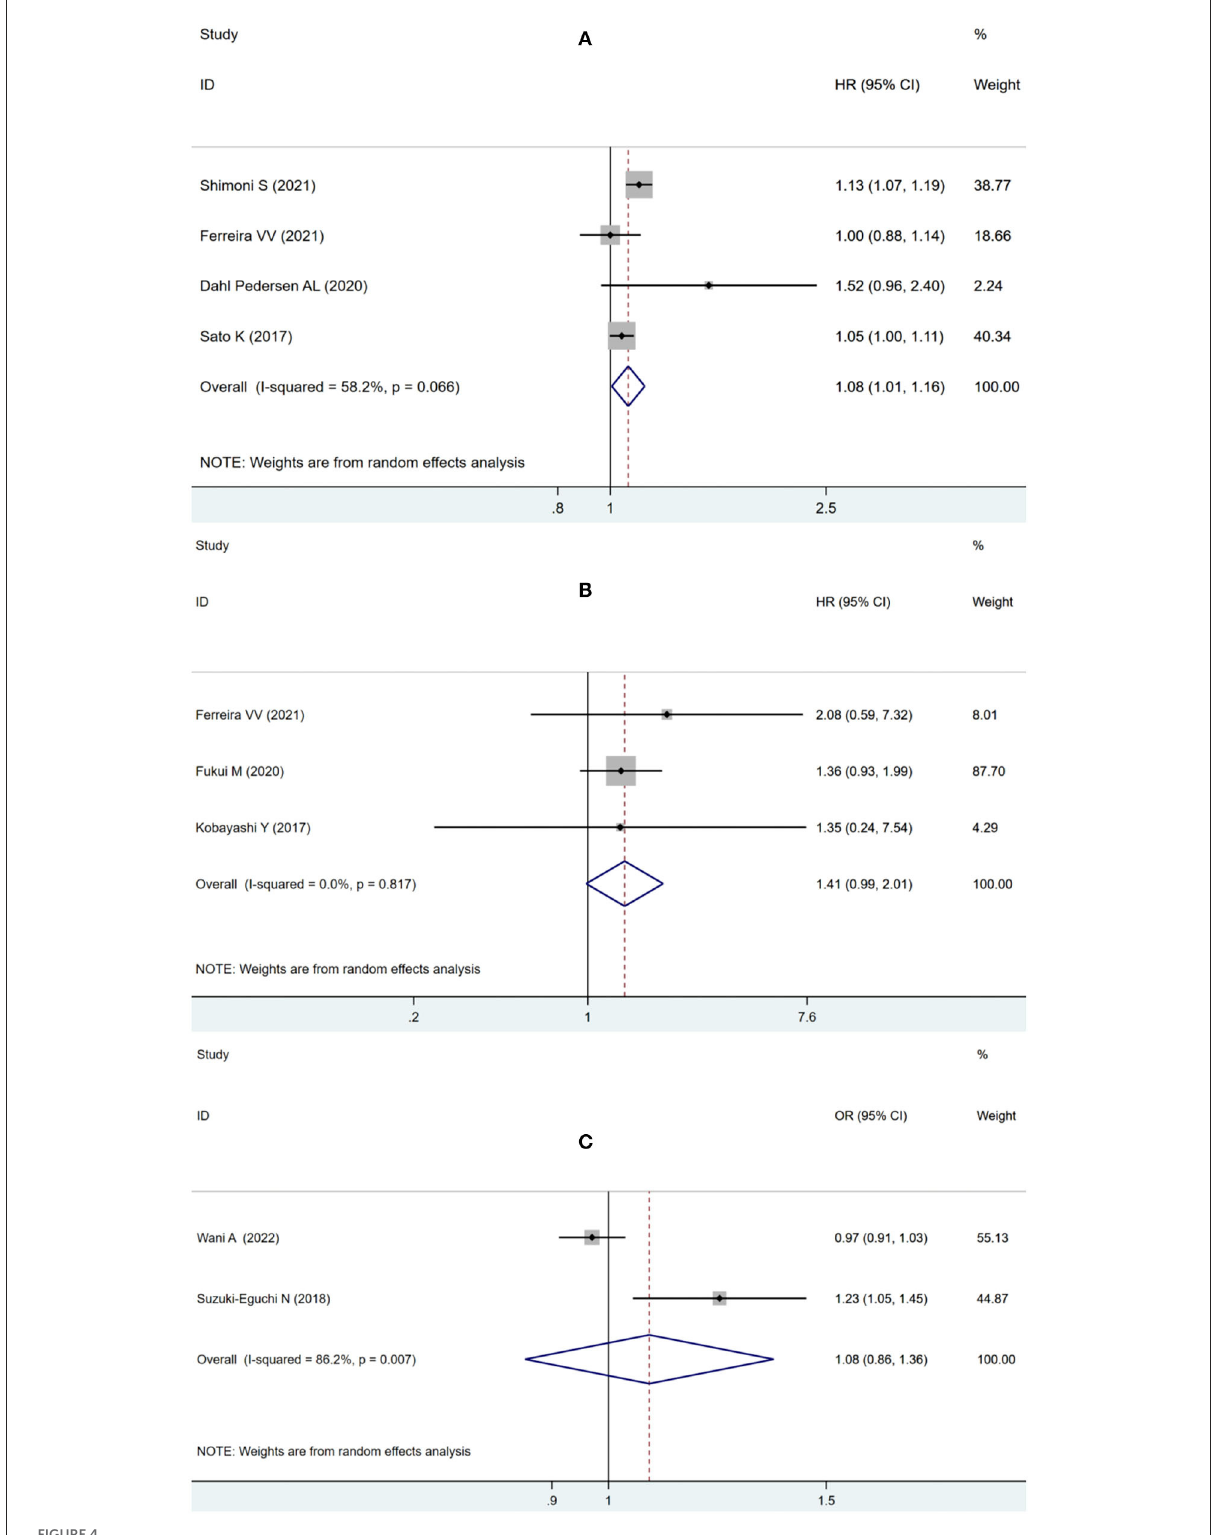
FIGURE4 Forest plot demonstrating the association between LVLS as continuous variable (A) or binary variable with previously reported cut-offs (B) and ACM in patients with AS undergoing TAVR; Forest plot demonstrating the association between LVLS and MACE in patients with AS undergoing TAVR (C)